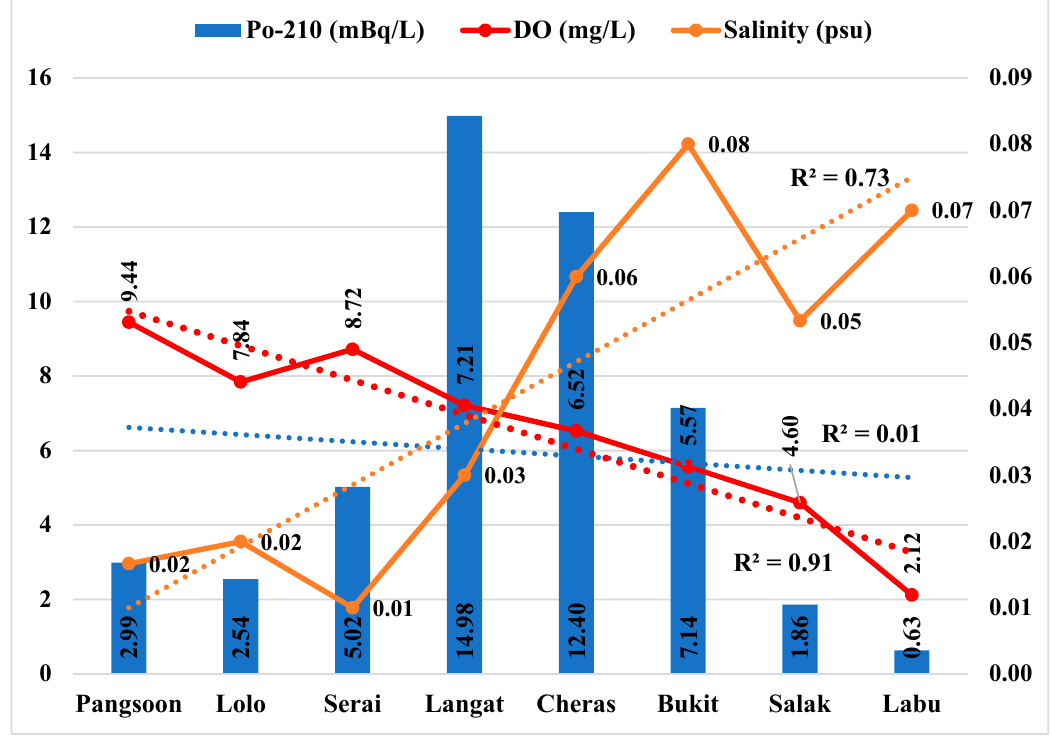
Figure 4. Po-210 activity in Langat River in relation with environmental parameters. Note: R² indicates the variance that is explained by the best-fit line from the upstream to the downstream of the Langat River.